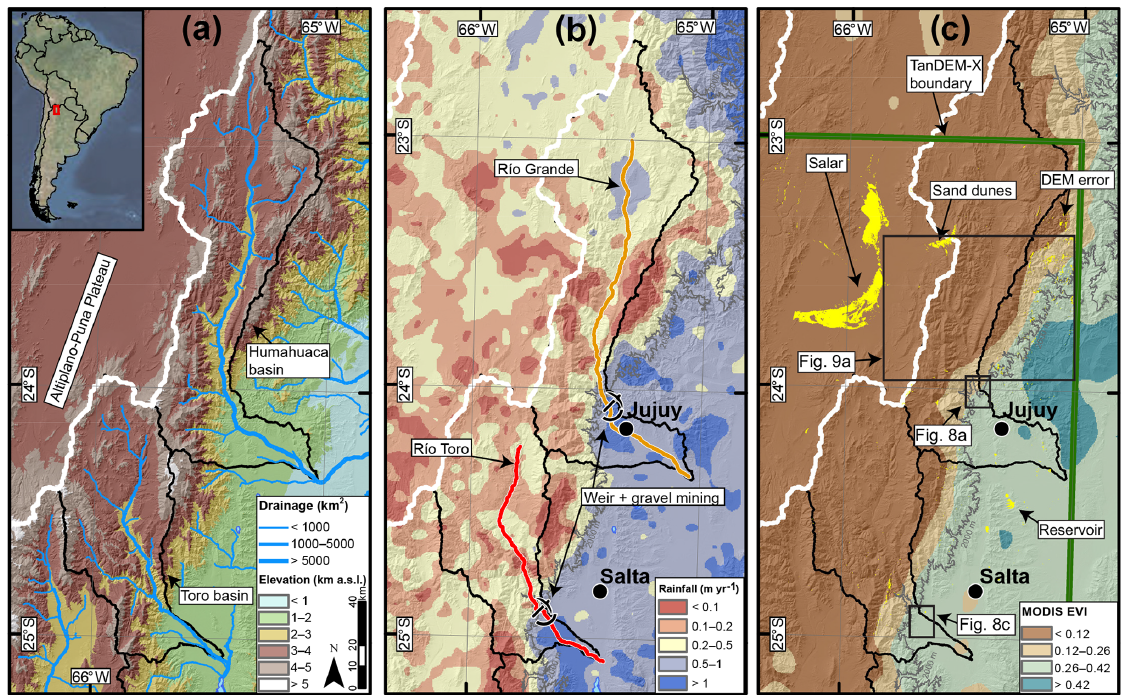
Figure 1. Overview of study area in NW Argentina with (a) elevation, (b) rainfall (Tropical Rainfall Measurement Mission 12-year average; TRMM2B31; Bookhagen and Strecker, 2008), and (c) vegetation (MODIS product 13C1 enhanced vegetation index 14-year average; MODIS EVI; Huete et al., 1994), where lower, brown (higher, green) values represent sparse (dense) vegetation. Note strong east–west gradients in all three maps. The white watershed boundary delineates the internally drained Altiplano–Puna Plateau. The gray line in (b) and (c) indicates the 2000m contour line. The yellow patches in (c) are areas identified in the TanDEM-X water indication mask (WAM) as having low amplitude and/or low coherence. These patches correspond to salt flat (salar) regions on the plateau, water bodies (e.g., reservoirs in the low-elevation areas), steep and vegetated areas (DEM error), and other zones of coherence loss, such as the dunes identified. Inset boxes in (c) indicate locations of dh map-view Figs. 8–9, with the TanDEM-X tile boundary in green. Note anthropogenic tampering of natural gravel-bed channels (Río Grande and Río Toro) with downstream flow diversion (weirs) and gravel mining activity near the populous cities of Salta and